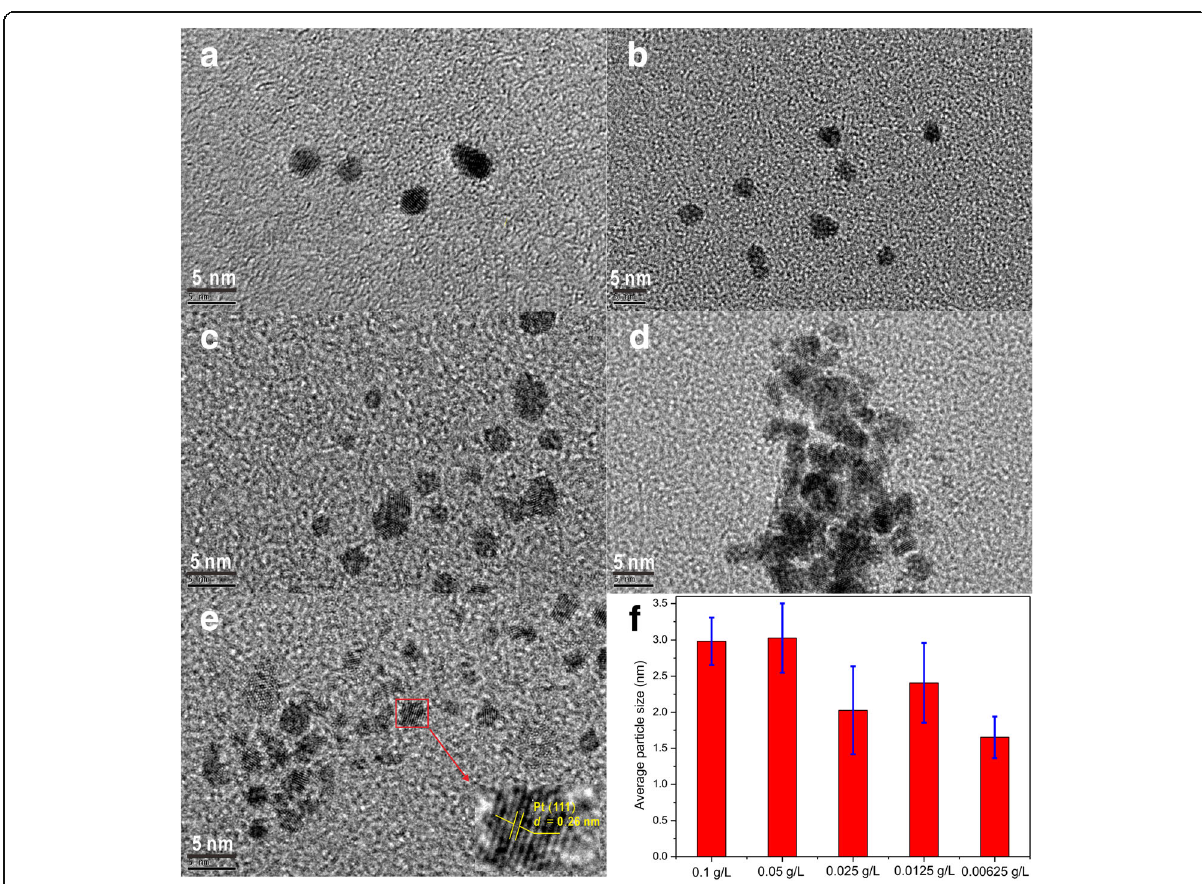
Fig. 2 HRTEM images of a – e Pt nanoparticles prepared by the acoustic levitation method with different metal concentrations (0.1, 0.05, 0.025, 0.0125, and 0.00625 g/L) and f average particle size for the Pt